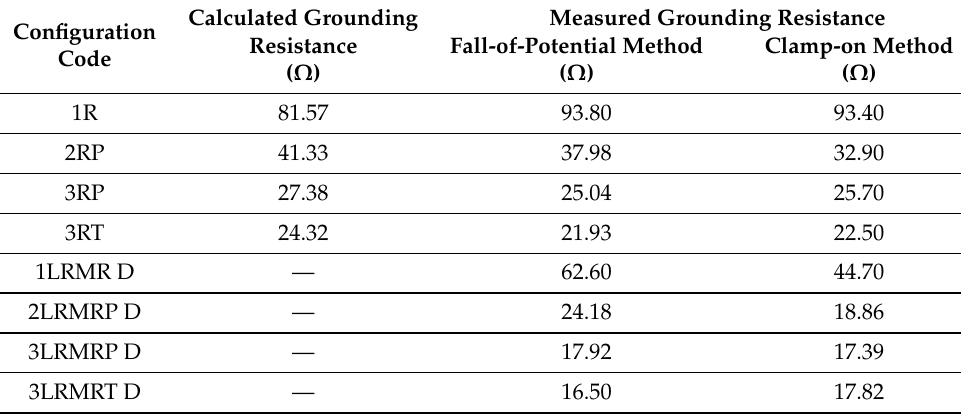
Table 6 outlines the calculated and measured GR values of the GSs implemented in soil 4 (S4), for which the resistivity was 159 Ω ·m. The dry LRM (D) was used in this soil. Table 6. GR calculations and measurements in